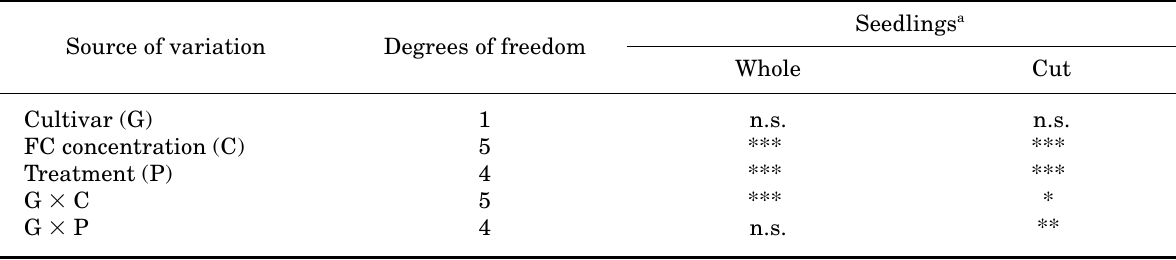
Table 1. ANOVA on the percent variation in weight (compared with controls) of seedlings of two cultivars of durum wheat during the experiments (4, 8, 24, 48 and 72 h). FC solutions were assayed at 5 concentrations (10 -7 –10 -5 M) on whole and cut seedlings. Control seedlings received distilled